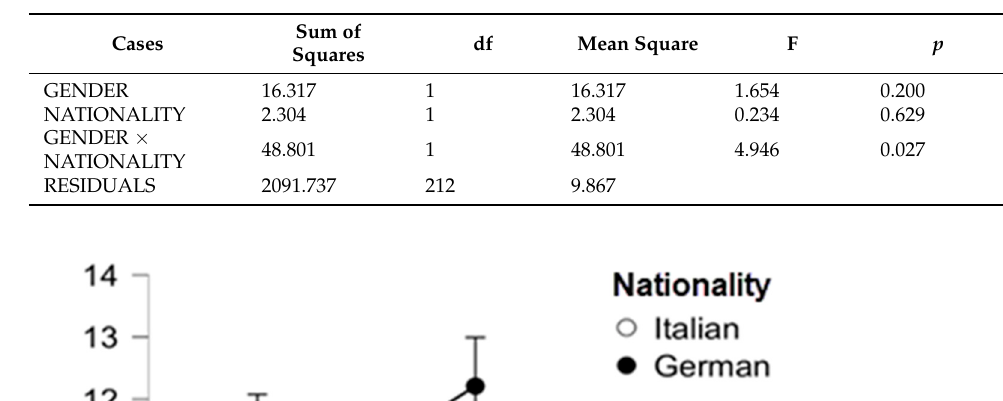
Table 6. Differences between nationality and gender on familiarity with visitors. The analysis was conducted with ANOVA Type III Sum of Squares.